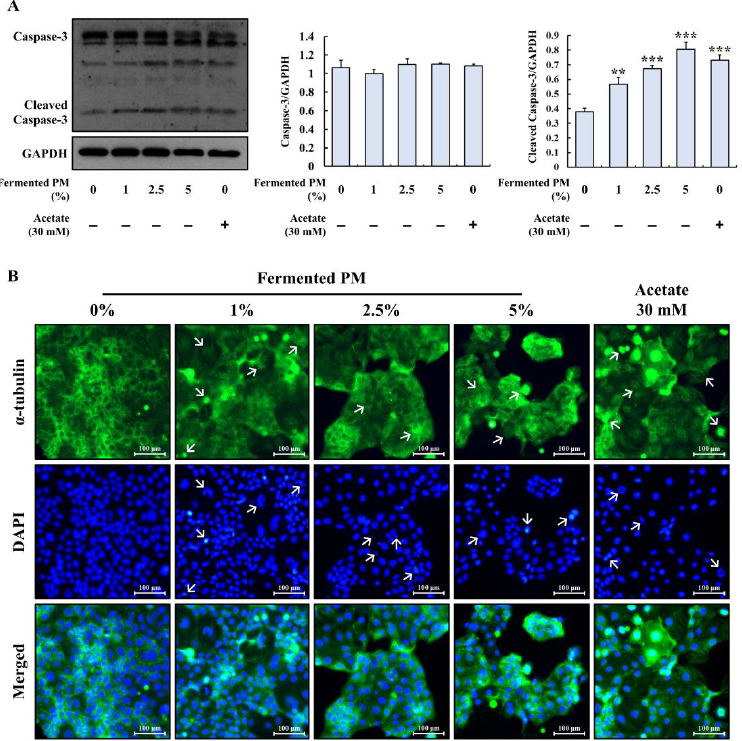
Figure 7. Effects of fermented PM and acetate on apoptosis markers, α -tubulin disruption, and cell nuclei damage in Caco-2 cells. ( A ) Protein expression of caspase-3 and cleaved caspase-3 and ( B ) fluorescence image s of α -tubulin and cell nuclei in Caco-2 cells. The magnification of the cell mor- phology image was 200 ×. Scale bar = 100 µm. White arrows indicate microtubule disruption and aggregation, and the nuclei condensation and fragmentation in Caco-2 cells. The cells were treated with fermented PM (0, 1, 2.5, and 5%) and acetate (30 mM) for 48 h ( n = 3 wells per groups). GAPDH was used as the loading control. Images are representative of three independent experiments. Re- sults are expressed as mean ± standard error ( n = 3). ** ( p < 0.01) and *** ( p < 0.001) indicate significant differences compared with the control.